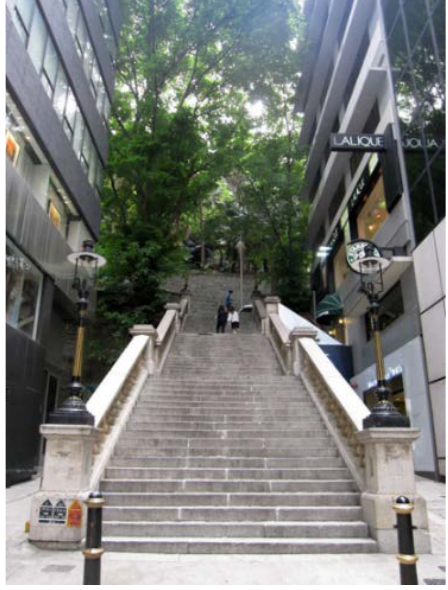
Figure 1: Duddell Street Steps and Gas Lamps, Central, Hong Kong before